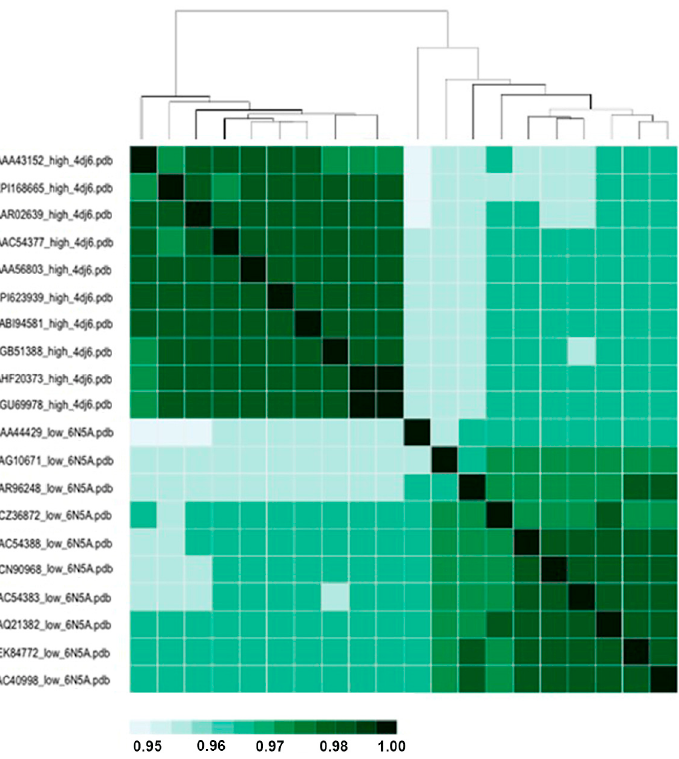
Figure 4. Bhattacharyya coefficient (BC) heatmap for HPAI and LPAI RBDs. Uniprot AC for each sequence, followed by pathogenicity and PDB of the template, are reported on the Y axis, while a distance tree is reported on the X axis.